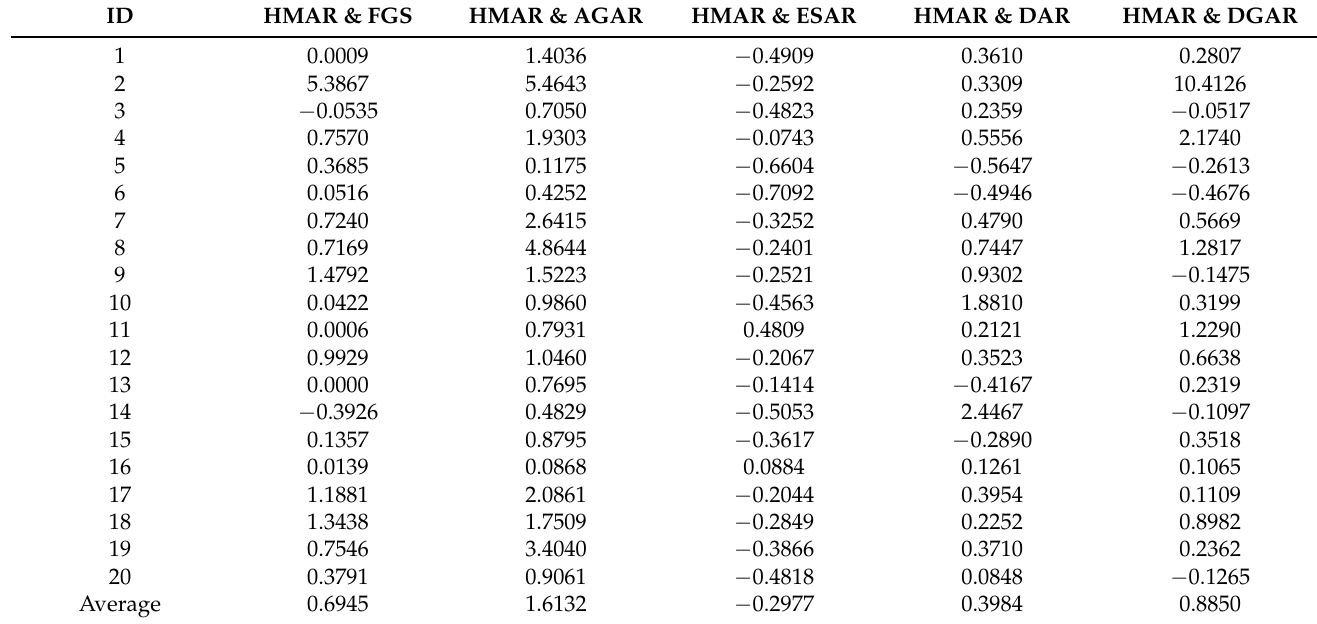
Table 3. The changing ratio related to stability of reducts based on Akashata’s measure.